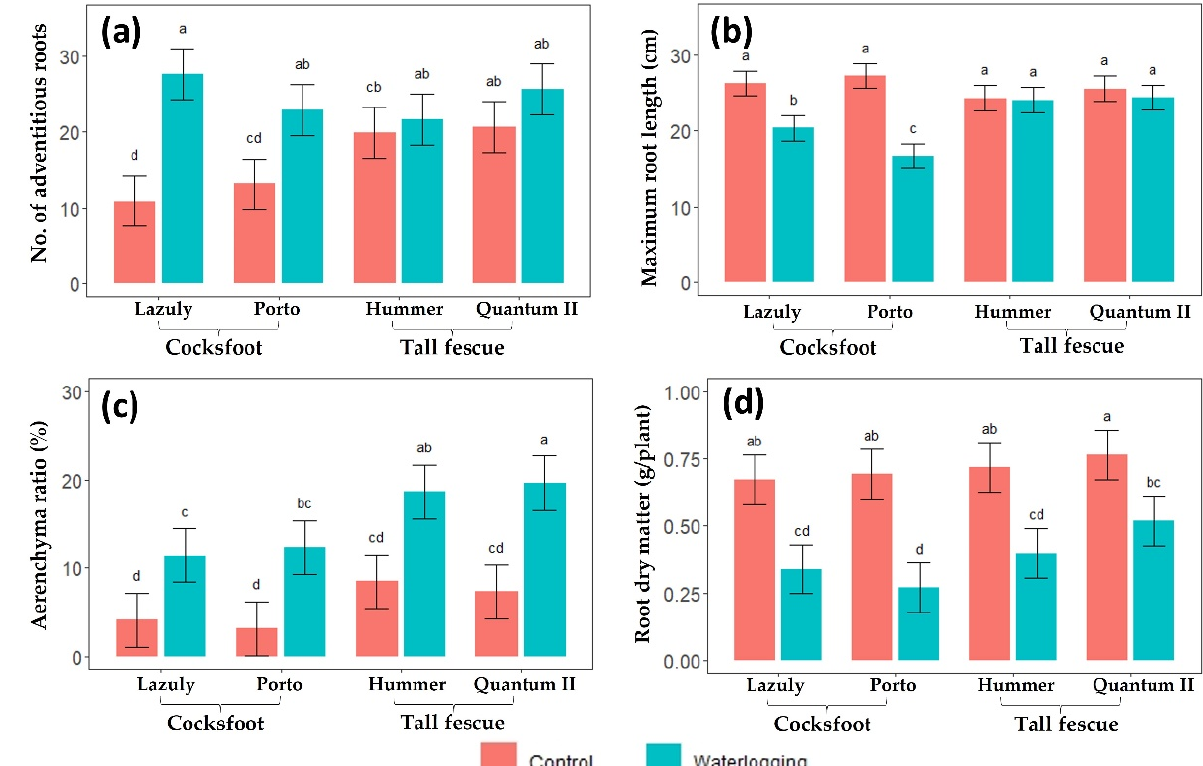
Figure 6. Responses of four cultivars (Lazuly, Porto, Hummer and Quantum II) to 28-day waterlogging via below-ground variables: ( a ) number of adventitious roots, ( b ) maximum root length, ( c ) aerenchyma ratio and ( d ) root dry matter. Values given are least squares means of four replicates and error bars indicate 95% confidence intervals of the least squares means. For each variable, least squares means sharing the same letters are not significantly ( p > 0.05)